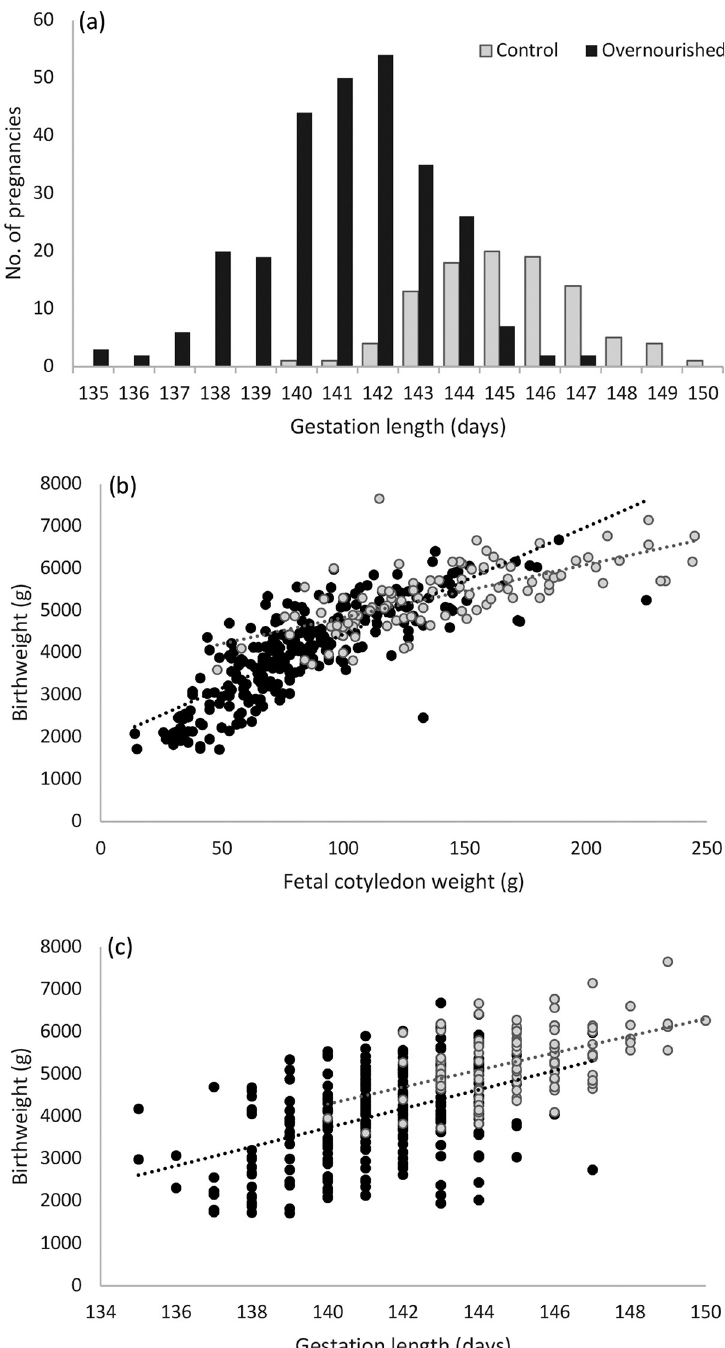
Fig 1. Individual birth parameters for study population in relation to gestational intake. Distribution of gestation length (a) and relationship between total fetal cotyledon weight and birthweight (b), and between gestation length and birthweight (c), in singleton bearing adolescent ewes offered a control intake or overnourished throughout pregnancy. For control (grey symbols) and overnourished (black symbols) pregnancies in (b) r = 0.687 and 0.808, and in (c) r = 0.484 and 0.430, all P < 0.001.